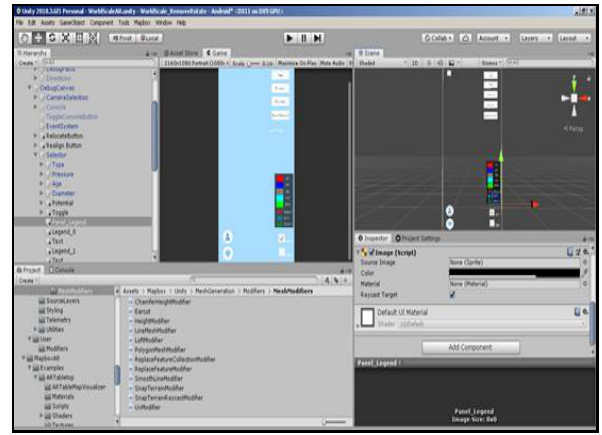
Figure 7. Unity3D integrated with Mapbox SDK for Unity